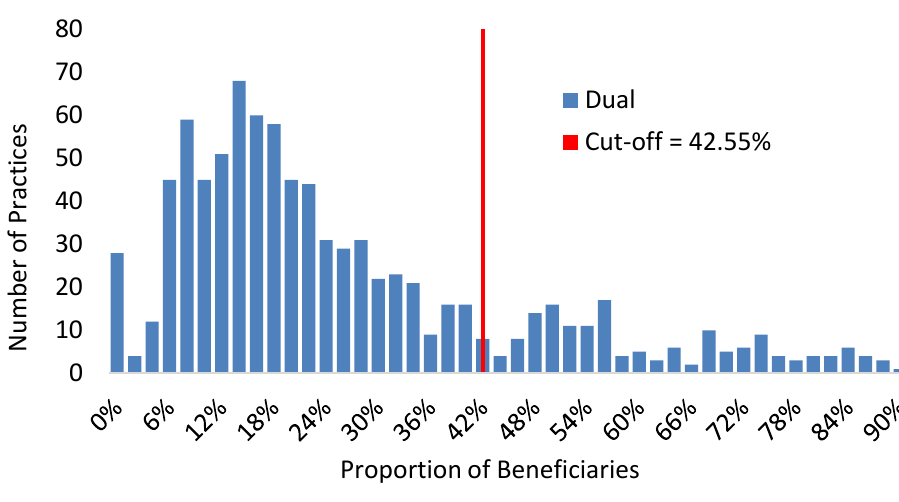
Figure 10.2. Distribution of Complex Beneficiaries by